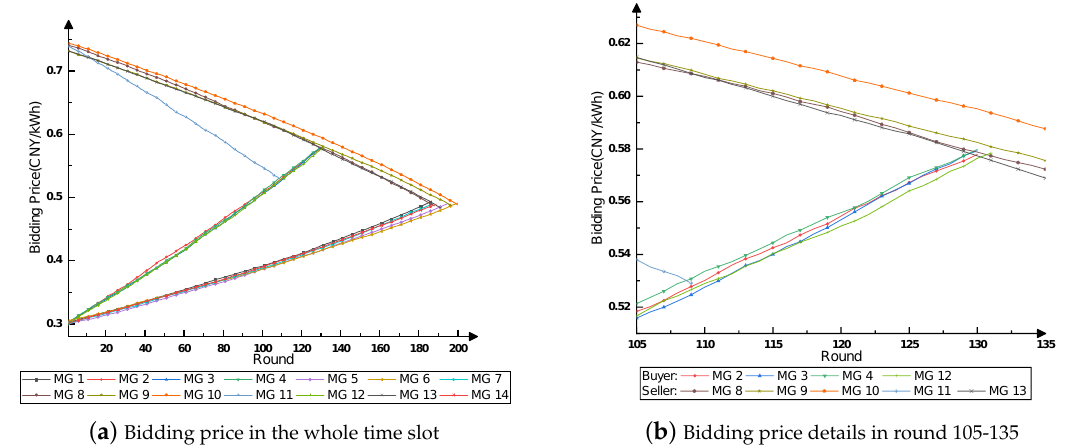
Figure 10. The bidding process of price in time slot